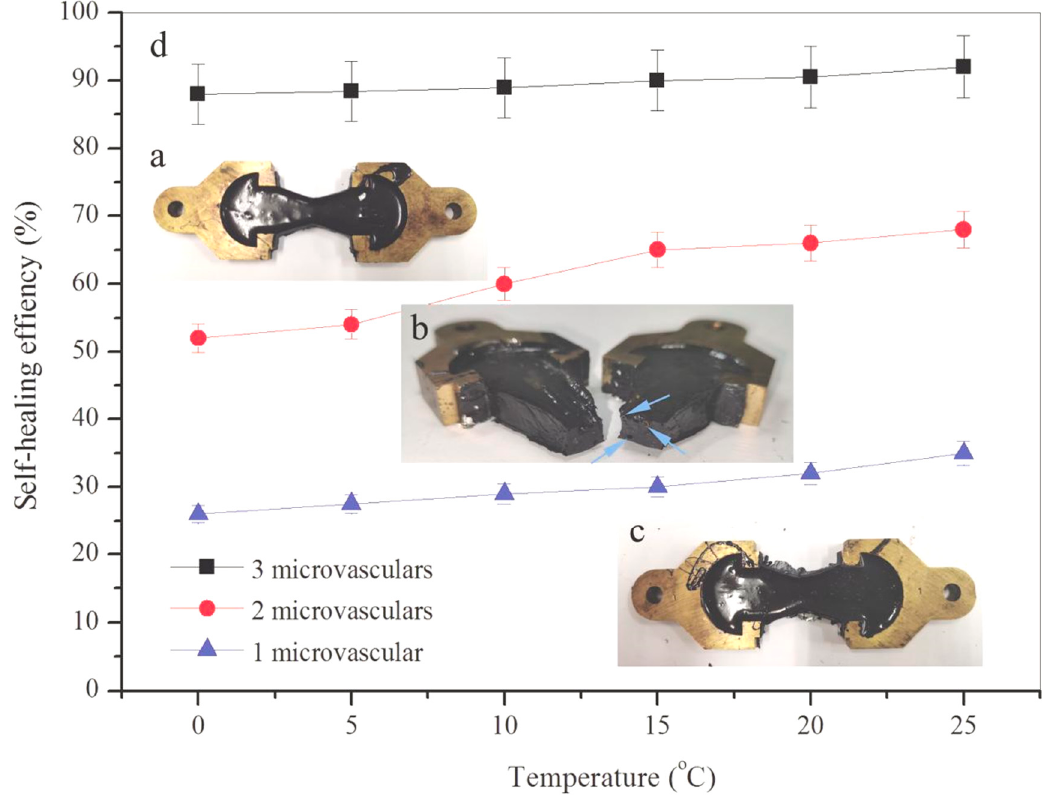
Figure 12. Self-healing efficiency (SHC) values of asphalt samples, ( a – c ) photos of self-healing process of bitumen, ( d ) SHC values of asphalt samples with 1–3 microvasculars influenced by self-healing temperature in one self-healing cycle under temperature of 0, 5, 10, 15, 20 and 25 °C.